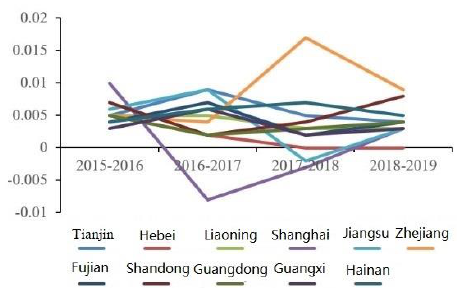
Figure 7 . Provincial change trend of land development intensity in coastal zones